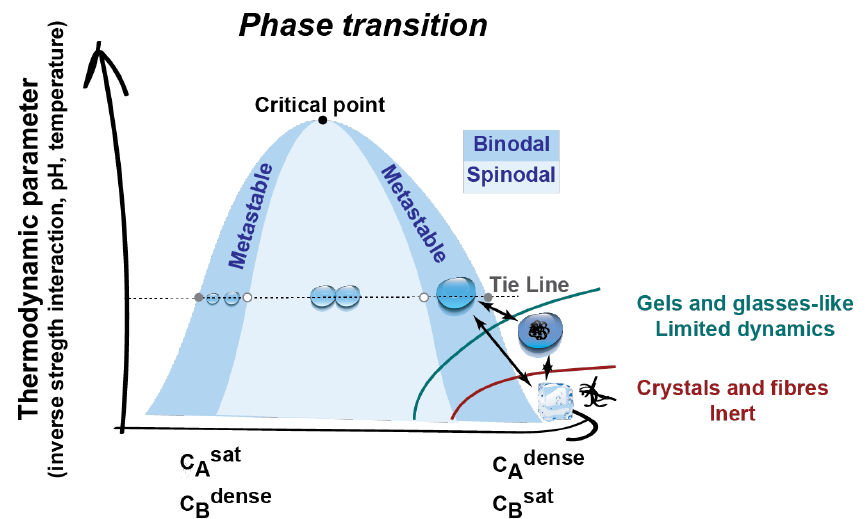
Figure 3. Phase diagrams with liquid, gels, and crystals. Biomolecular condensates can display a range of material properties from liquids with high dynamics to gels, hydrogels, and glasses that are less dynamic and to inert crystals or fibers as observed in neurodegenerative disorders. Phase transitions are possible by manipulating either the concentration, PTMs, valency, and strength of interactions (as happens in mutations) or by changing thermodynamic parameters such as ionic strength, temperature, pH,